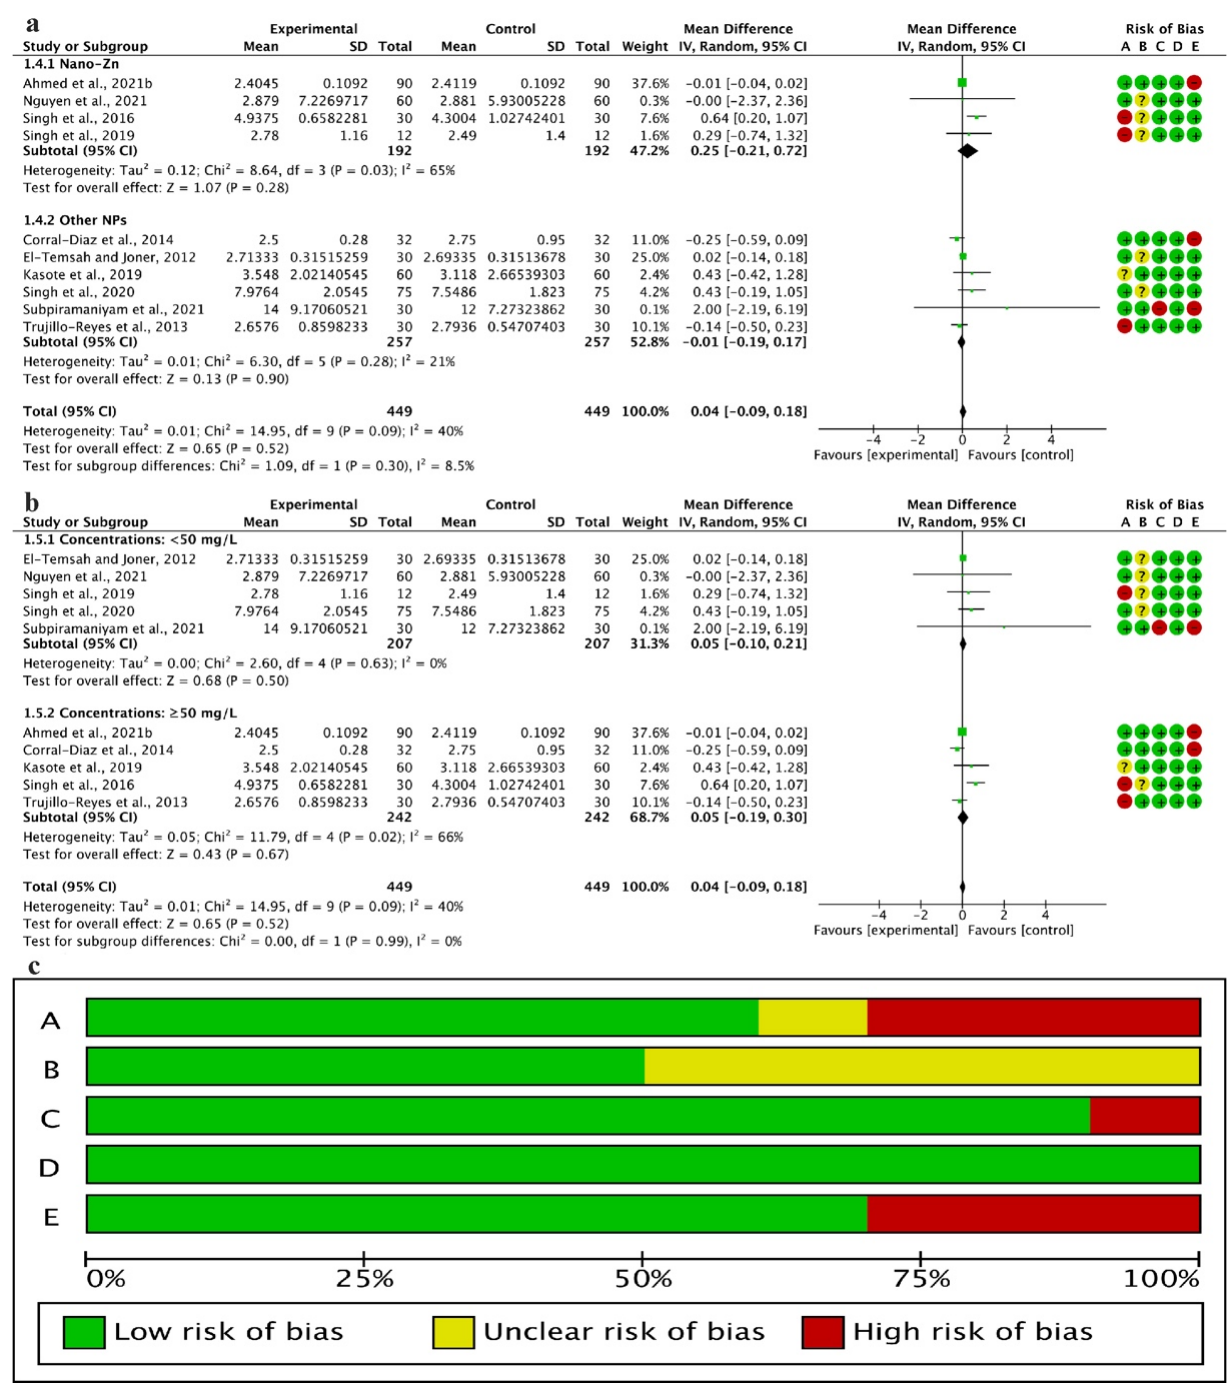
Figure 6. Heterogeneity evaluation, subgroup analysis, and risk of bias assessment for SL. ( a ) Sub- group analysis for NP types; ( b ) subgroup analysis for NP concentrations; ( c ) risk of bias assessment.